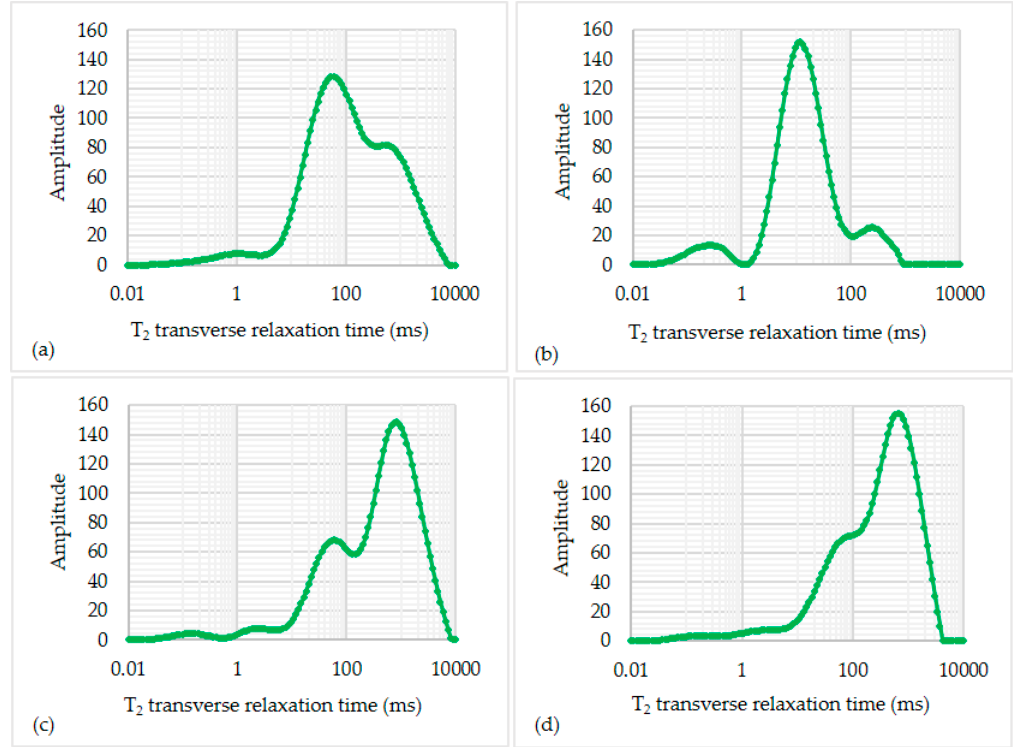
Figure 6. Typical T 2 relaxation curves observed for the core sample from the study area show various distributions of micro to macropores which result in the complex nature of the reservoir interval of the Sawan gas field, ( a ) sample S1, ( b ) sample S2, ( c ) sample S3, and ( d ) sample S4.